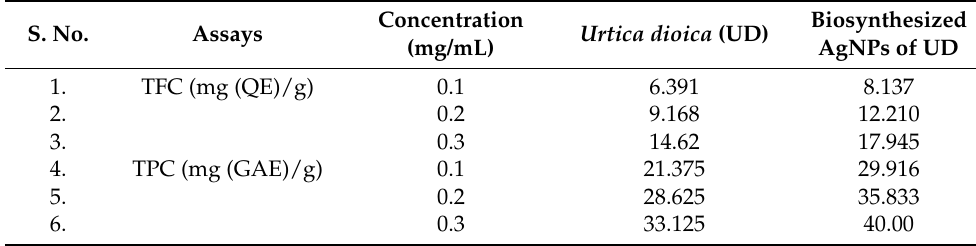
Figure 3. Total phenolic ( a ) and flavonoid ( b ) contents of Urtica dioica (UD) and biosynthesized silver nanoparticles of UD (UD-AgNPs). The data are shown as the mean ± SD ( n = 3). Statistical significance was ascribed as * p < 0.05 (intergroup) and # p < 0.05 (intragroup) compared with and 0.1 mg/mL of the respective groups. Table 3. TPC and TFC results for UD and UD-AgNPs are shown as the mean ±